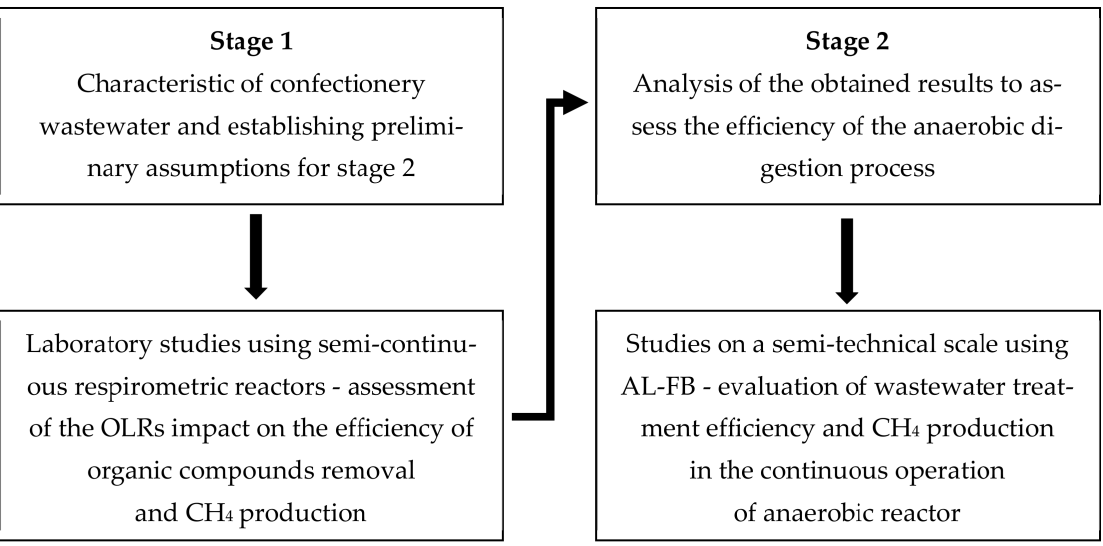
Figure 1. The study